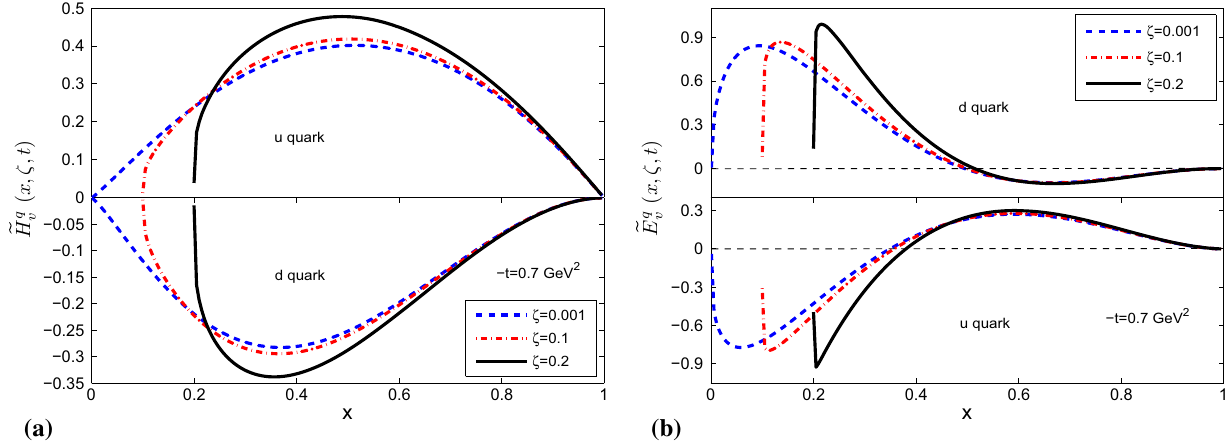
Fig. 2 (Color online) Plots of helicity-dependent GPDs for the nonzero skewness vs. x and different values of ζ , for a fixed value of t = − 0 . 7 GeV 2 . a (cid:2) H q v and b (cid:2) E q v ; q stands for the u and d